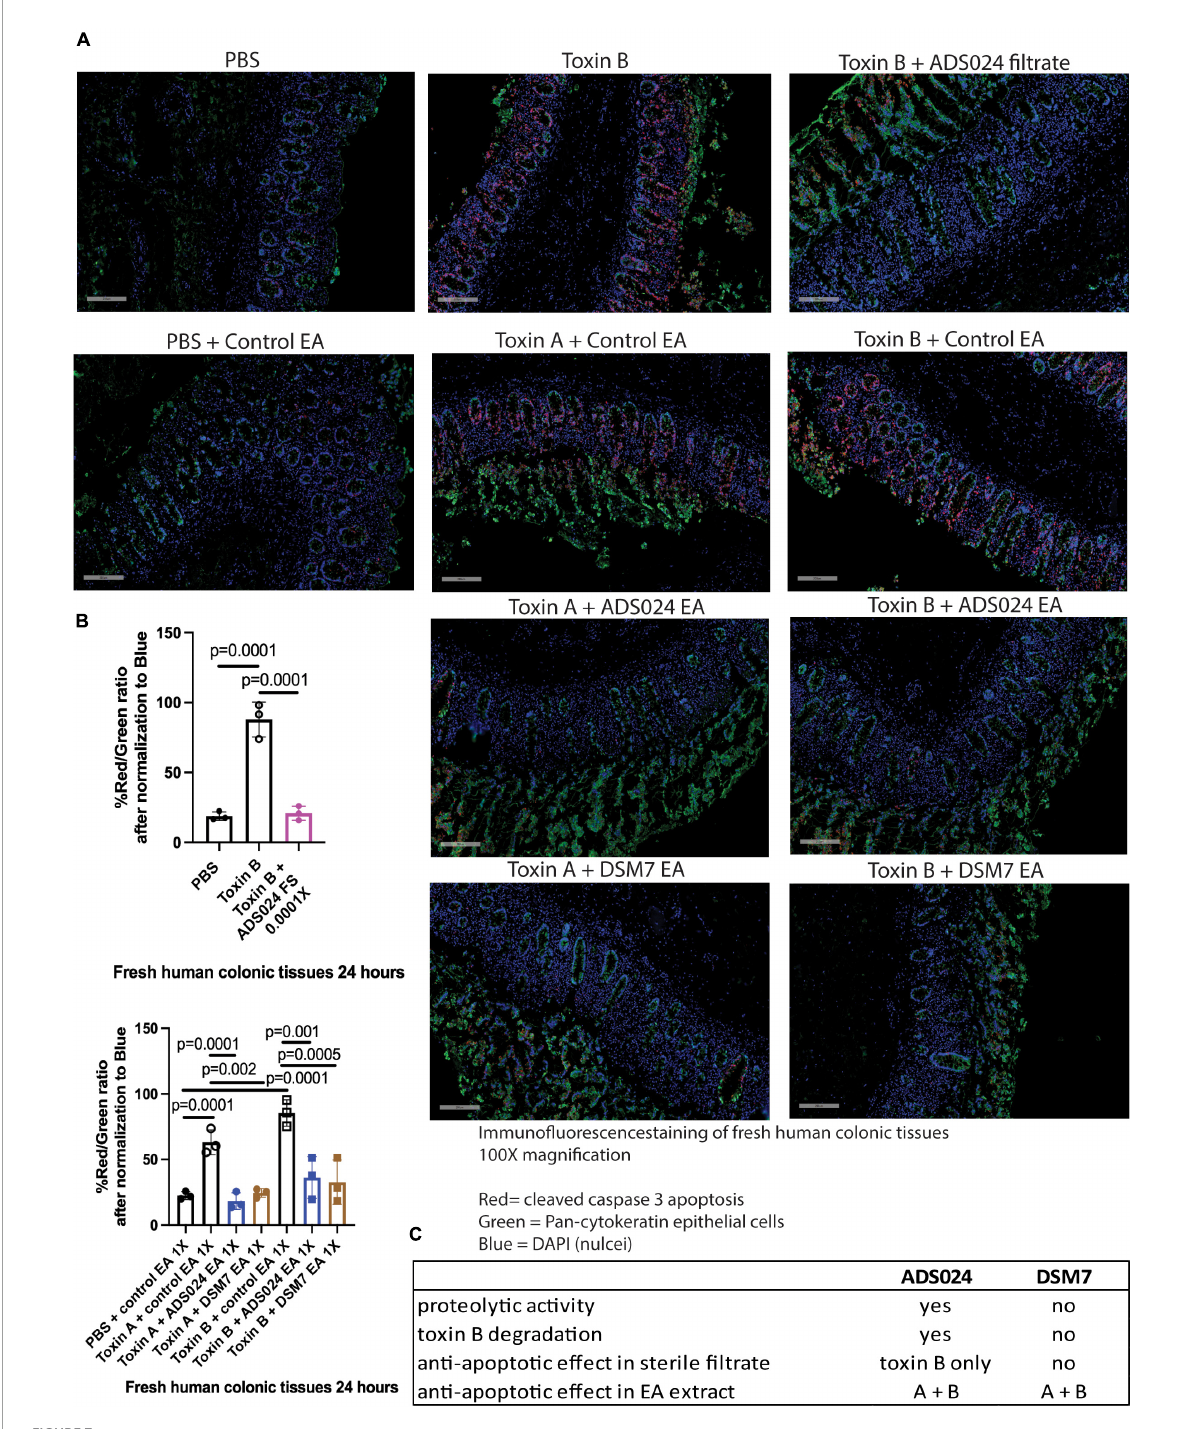
FIGURE7 ADS024 inhibited caspase three cleavage in toxin-treated human colonic explants. (A) Immunofluorescence staining of cleaved caspase 3 (red), pan-cytokeratin (green), and nuclei (blue) in fresh human colonic explants treated with or without toxin A, toxin B, PBS, ADS024 filtrate, control EA, ADS024 EA, or DSM7 EA. The gray bars in the lower-left corner indicate 200 microns. Apoptosis (red, cleaved caspase) occurred in colonic epithelial cells (green, pan-cytokeratin) as red and green signals either overlapped or in proximity. (B) Quantitative analysis of images representing cleaved caspase three (red) and epithelial cells (green) ratio after normalized to blue nuclear signal. The high red/green ratio represented increased apoptosis. Toxin B-mediated cleaved caspase three was reduced by ADS024 filtrate treatment. Toxin A- and toxin B-mediated caspase three cleavages were reduced by ADS024 and DSM7 EA extract treatment. Results were representative of samples from 10 patients. One-way ANOVA tests were used. (C) A comparison of ADS024 and DSM7